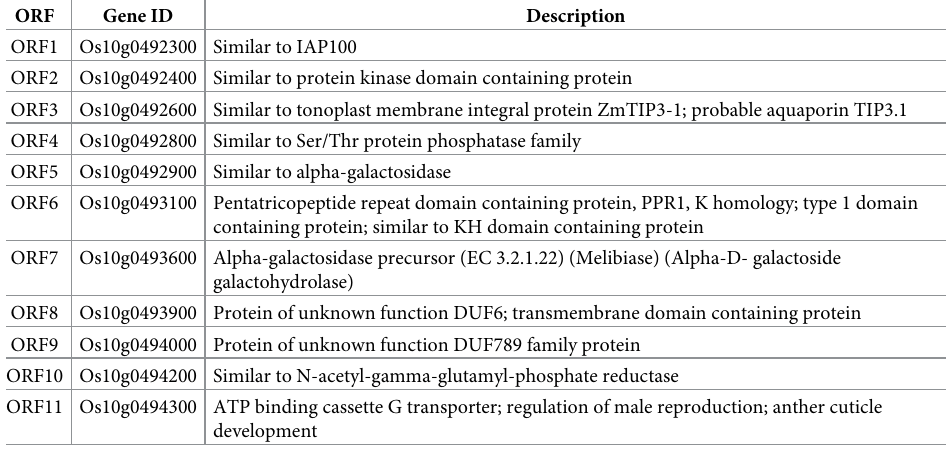
Table 1. Candidate genes in the genomic region between M2099 and FM07